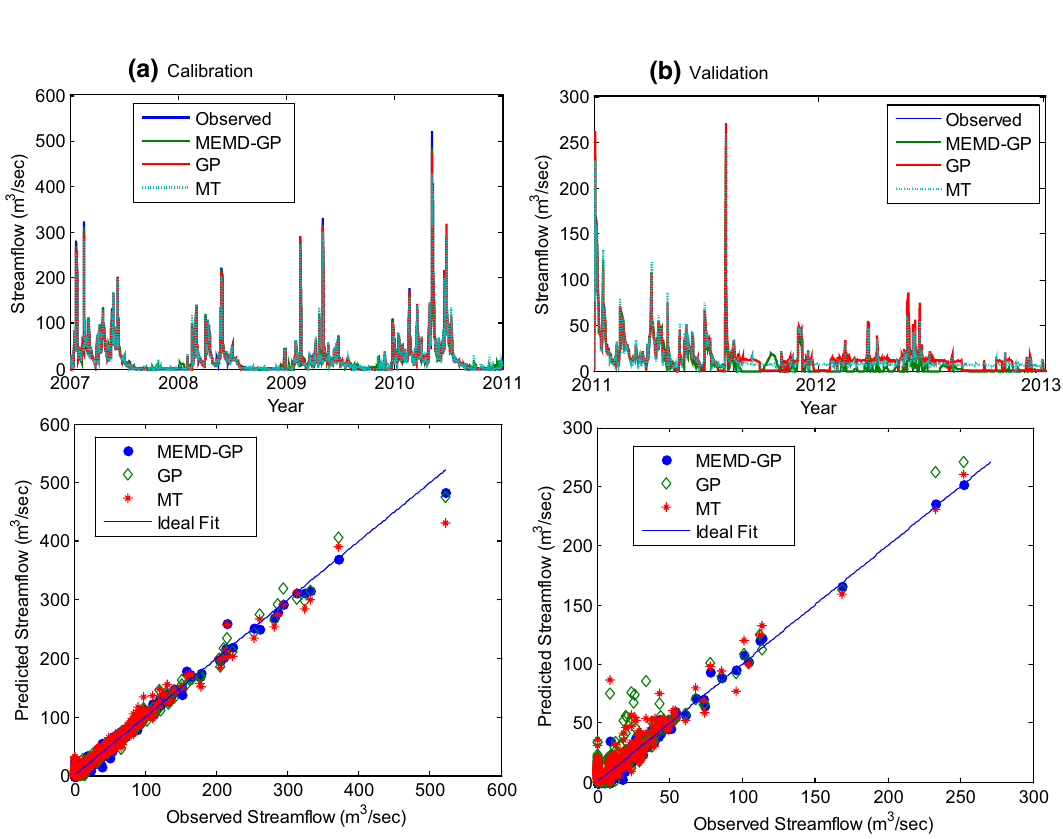
Fig. 5 Daily discharge predictions for Ayilam station by different methods. Upper panels show time series plots; lower panels show scatter